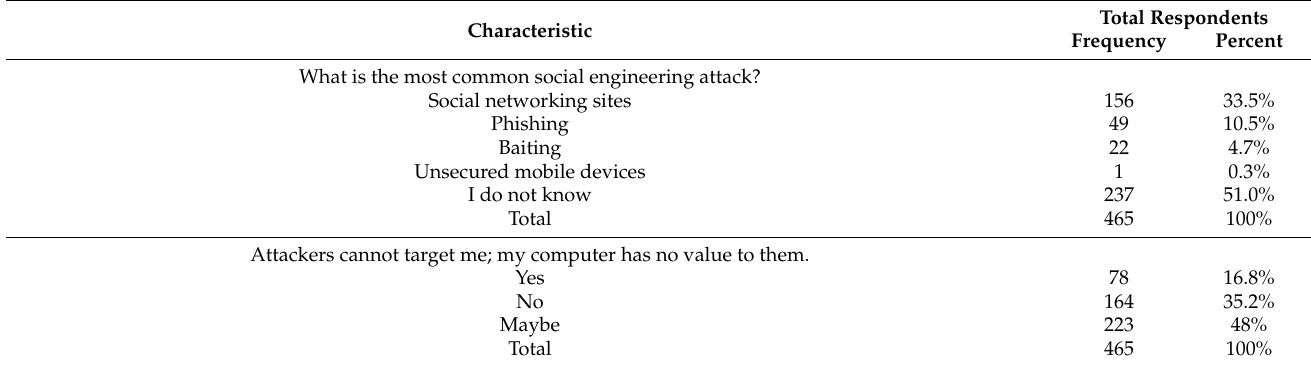
Table A1. Awareness of social engineering approaches and related